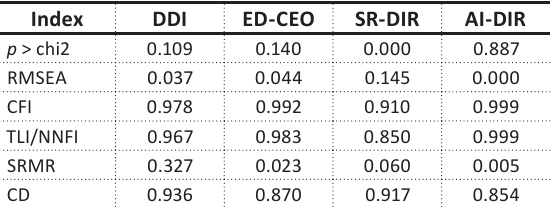
Table 6. Indexes of goodness adjustment